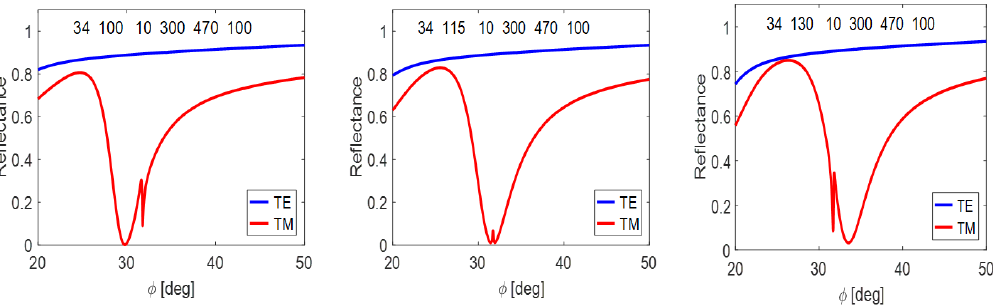
Figure 8. Mutual coupling of the TM 3 waveguide mode and the long-range plasmonic mode tuned by the t i size. The layer proportions are specified for each